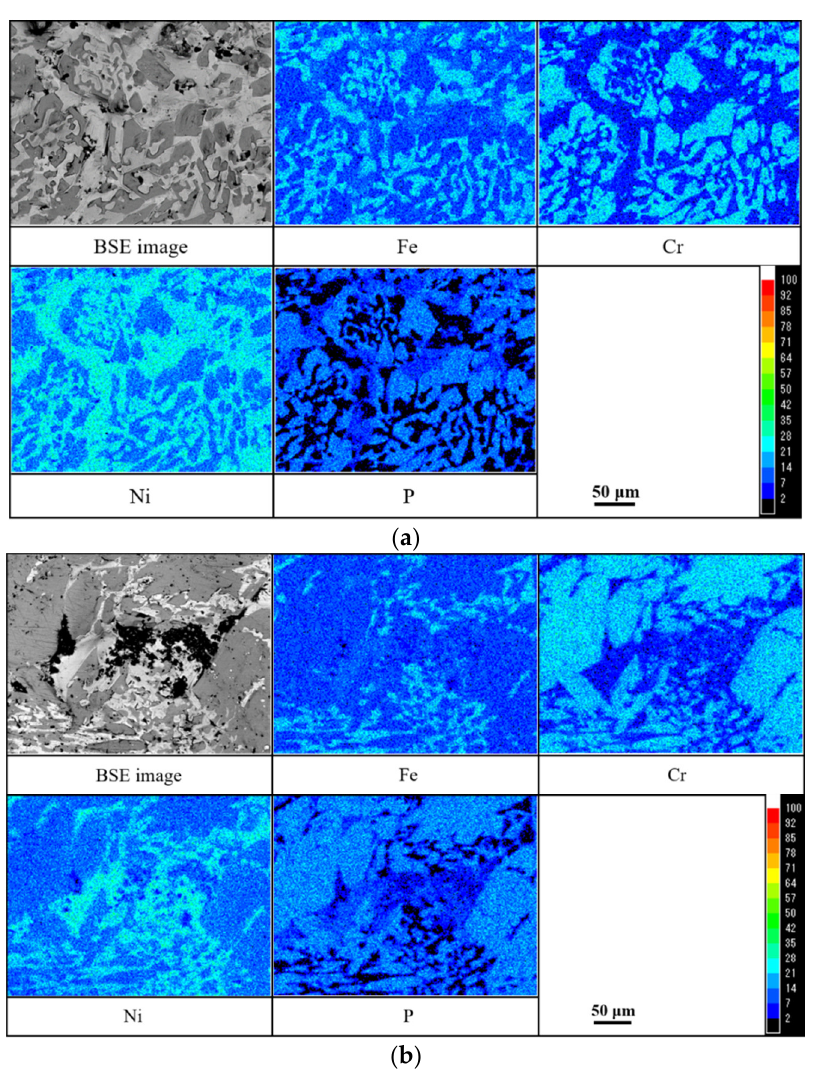
Figure 13. Mapping analysis for surface of brazed Ni-13.4Cr-11.6P alloy coating. Before galvanic current measurement ( a ) and after galvanic current measurement ( b ).